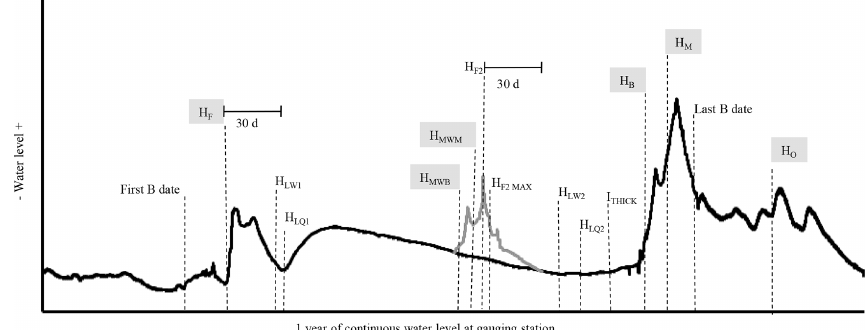
Figure 3. Conceptual schematic of a continuous river water level hydrograph (black line) spanning 1 September to 31 August. The period of ice-affected flow is constrained by the first B date and last B date. A possible midwinter break-up event is shown as a grey line at the approximate centre of the hydrograph. Symbols for the 15 variables that populate the Canadian River Ice Database are shown in the figure (see Table 2 for additional information). The variables shaded in grey show the instantaneous water level and associated time when the event occurred. Compression of the x axis and vertical exaggeration of the y axis accentuate the water level changes observed during ice conditions. The relative magnitudes of variables and water level pathology should not be considered as typical.